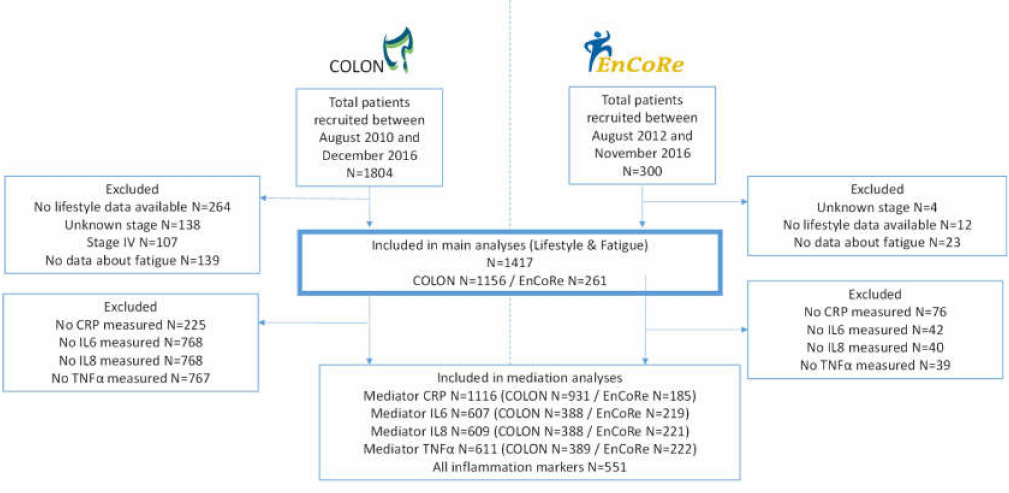
Figure 1. Flow diagram of patients included in this